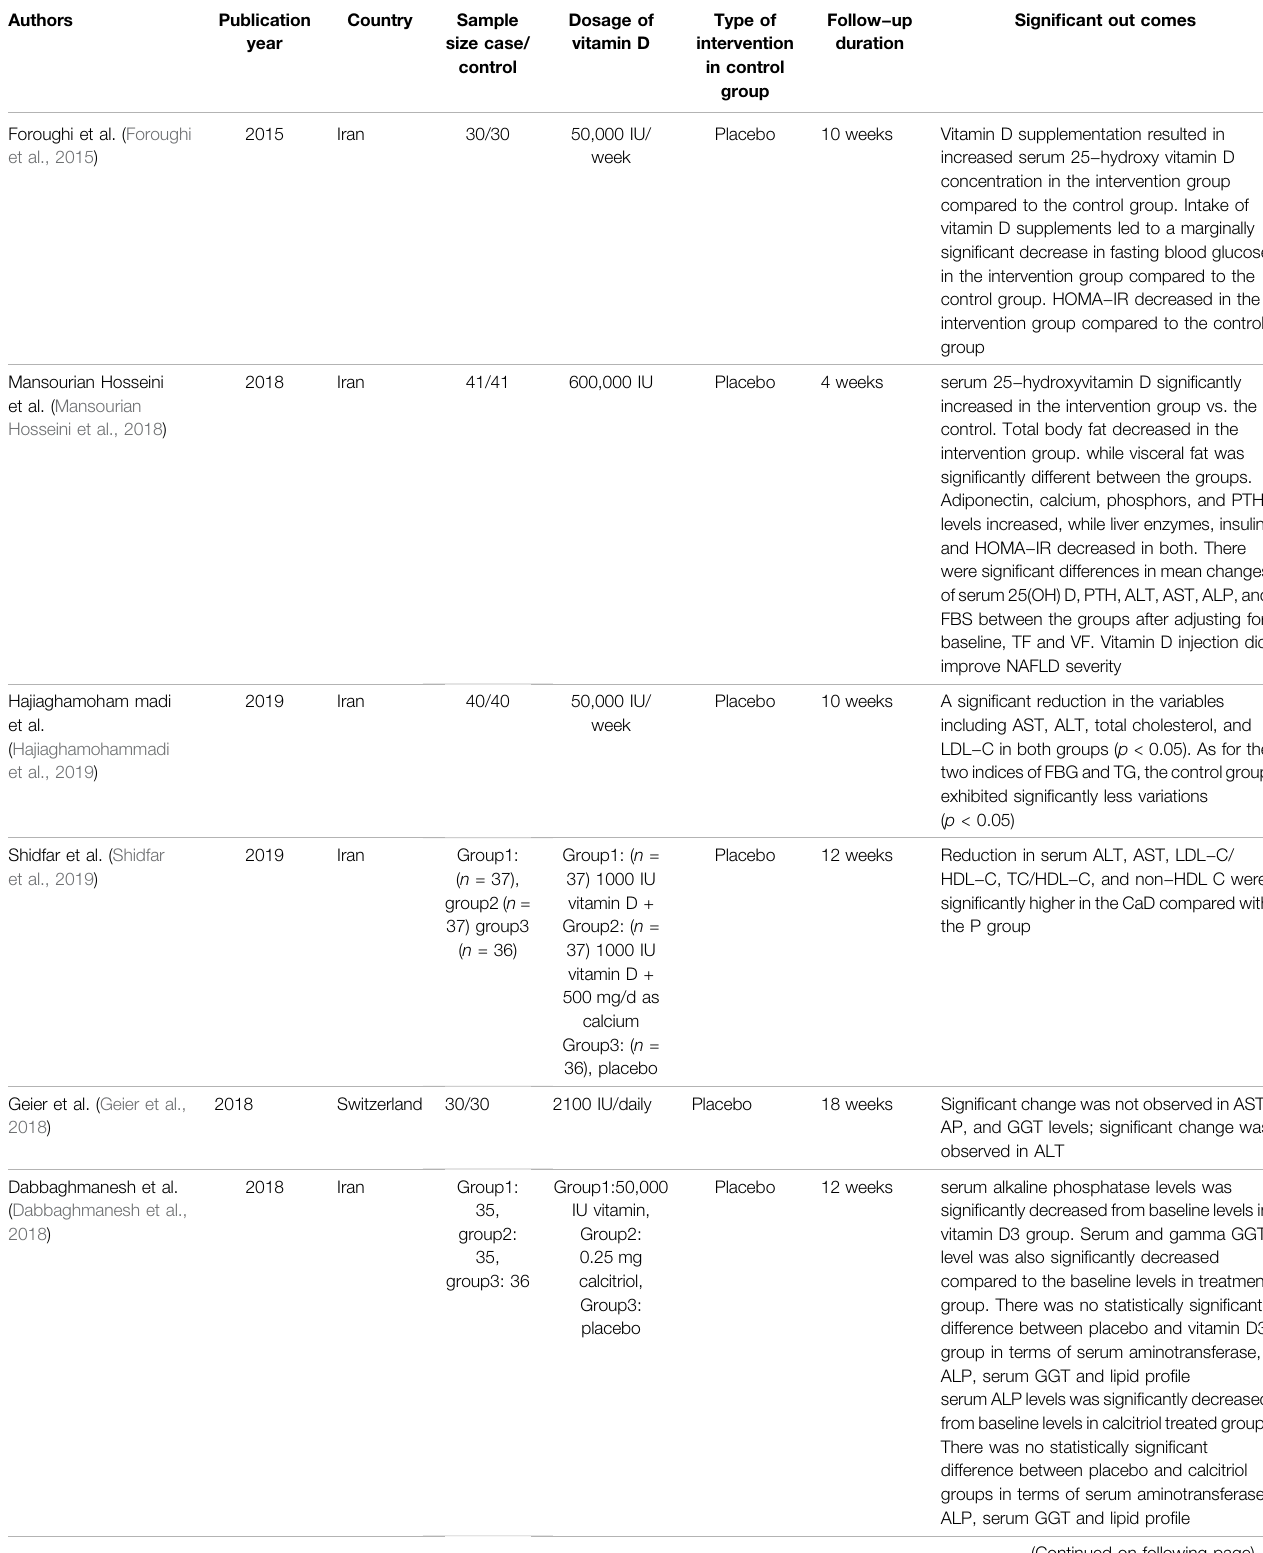
TABLE 1 | Characteristics of the primary studies included in the meta − analysis.